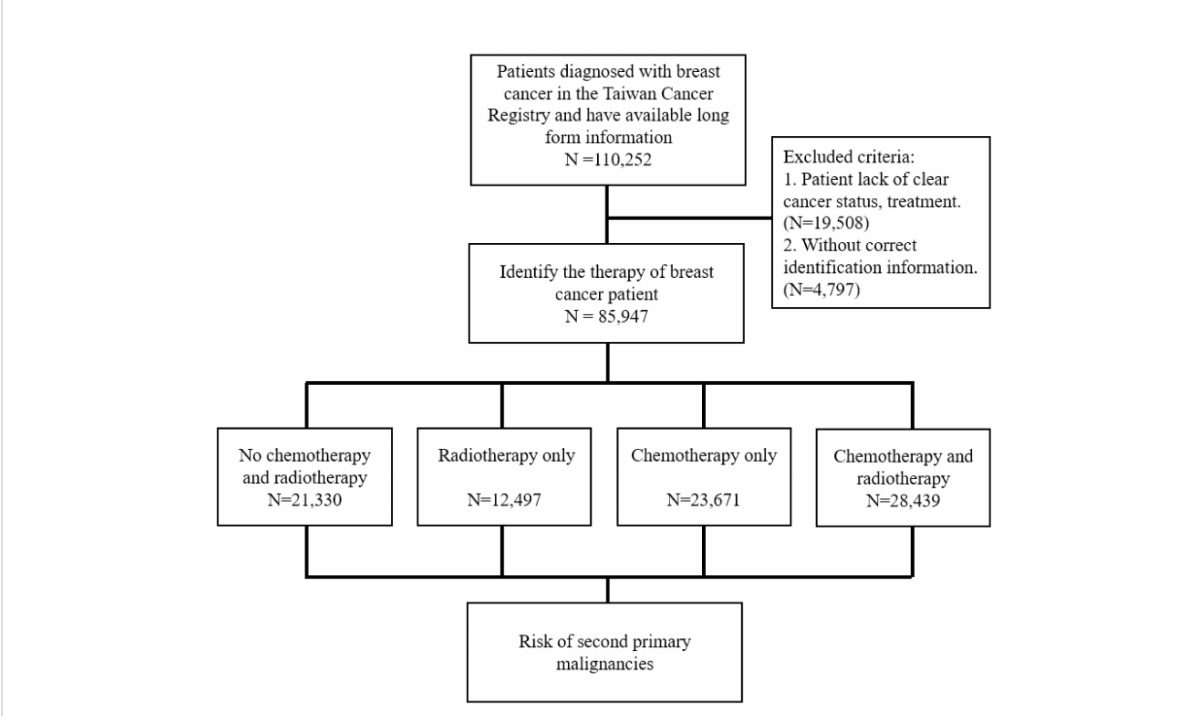
FIGURE 1 Diagram of risk evaluation for second primary malignancies from eligible women with breast cancer. ICD-9-CM: International Classi fi cation of Diseases, Ninth Revision, Clinical Modi fi cation, ICD-O-3: International Classi fi cation of Diseases for Oncology, Third